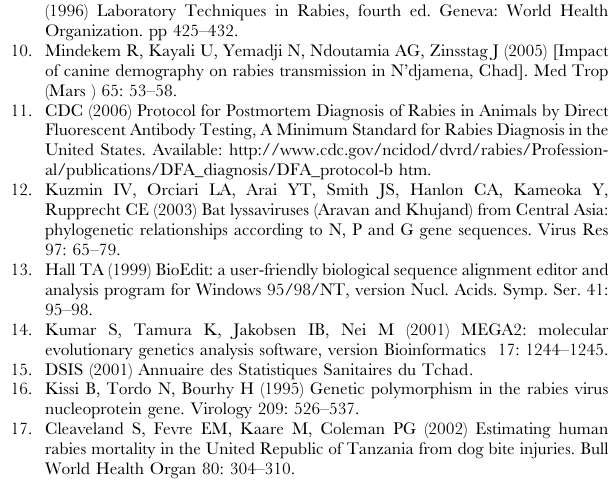
Figure S1 Example of filled out questionnaire at LRVZ (part of the routine data collection of rabies diagnosis at